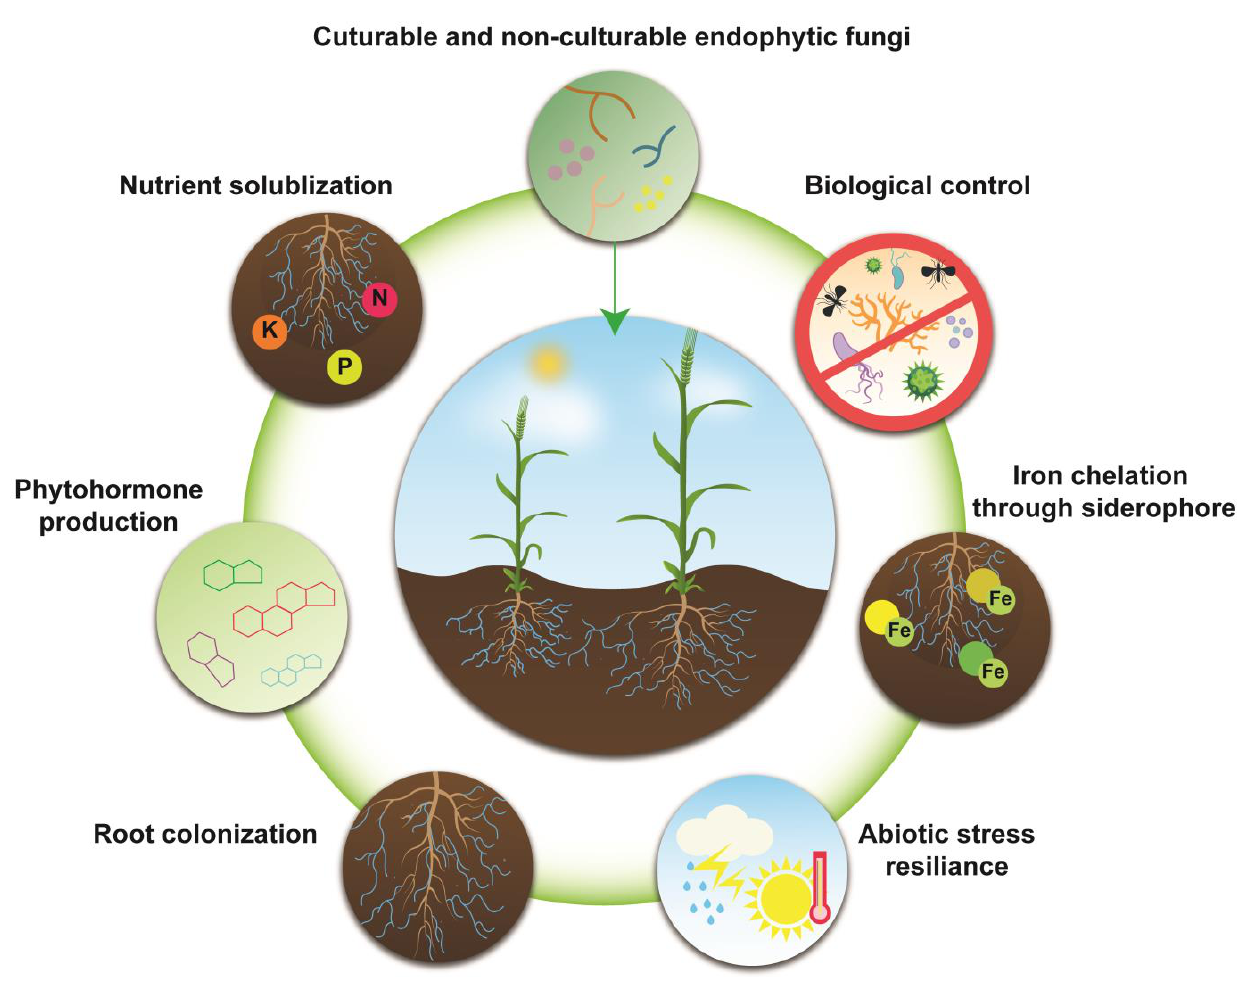
Figure 3. Potential roles of endophytes in